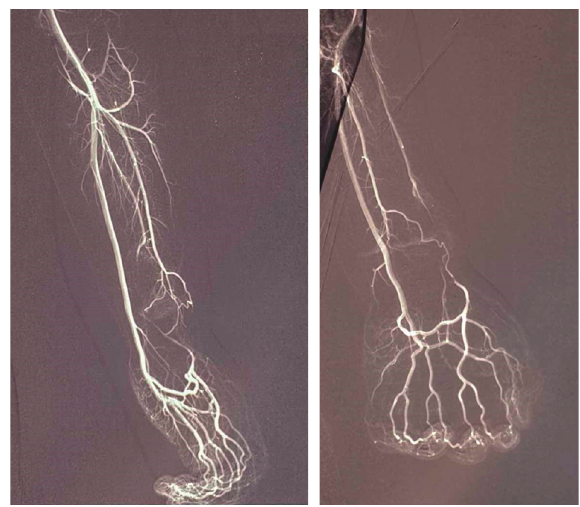
Figure 1: Radial artery aneurysm (arteriography